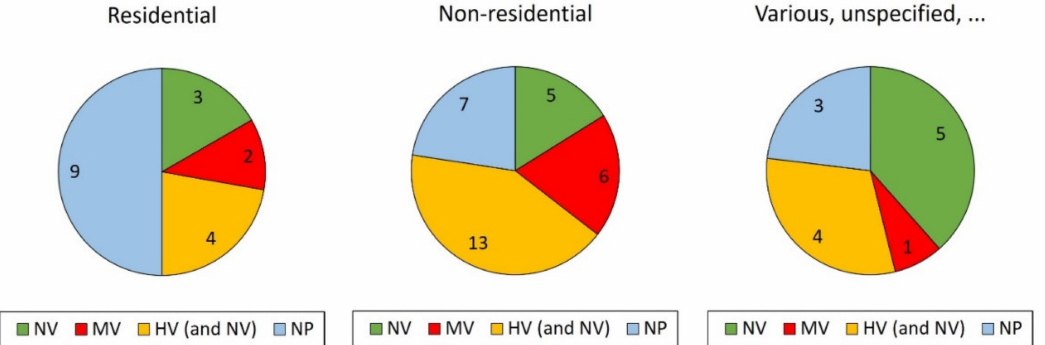
Figure 7. Type of ventilation suggested depending on building type. Numbers indicate the number of papers recommending each ventilation type. NV: natural ventilation; MV: mechanical ventilation; HV: hybrid ventilation; NP: no